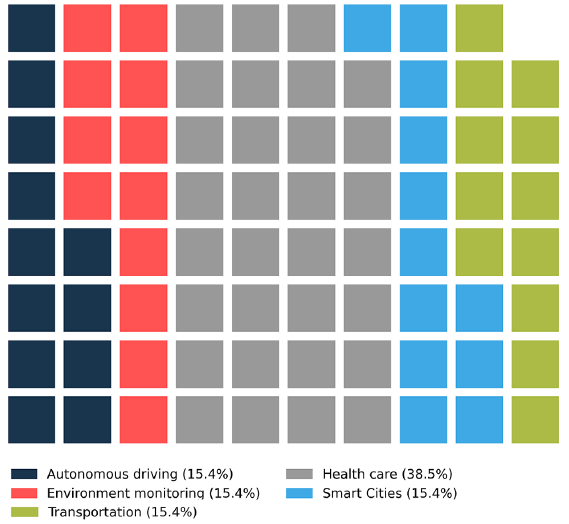
Figure 15. The relationship between QoS and top five most studied application